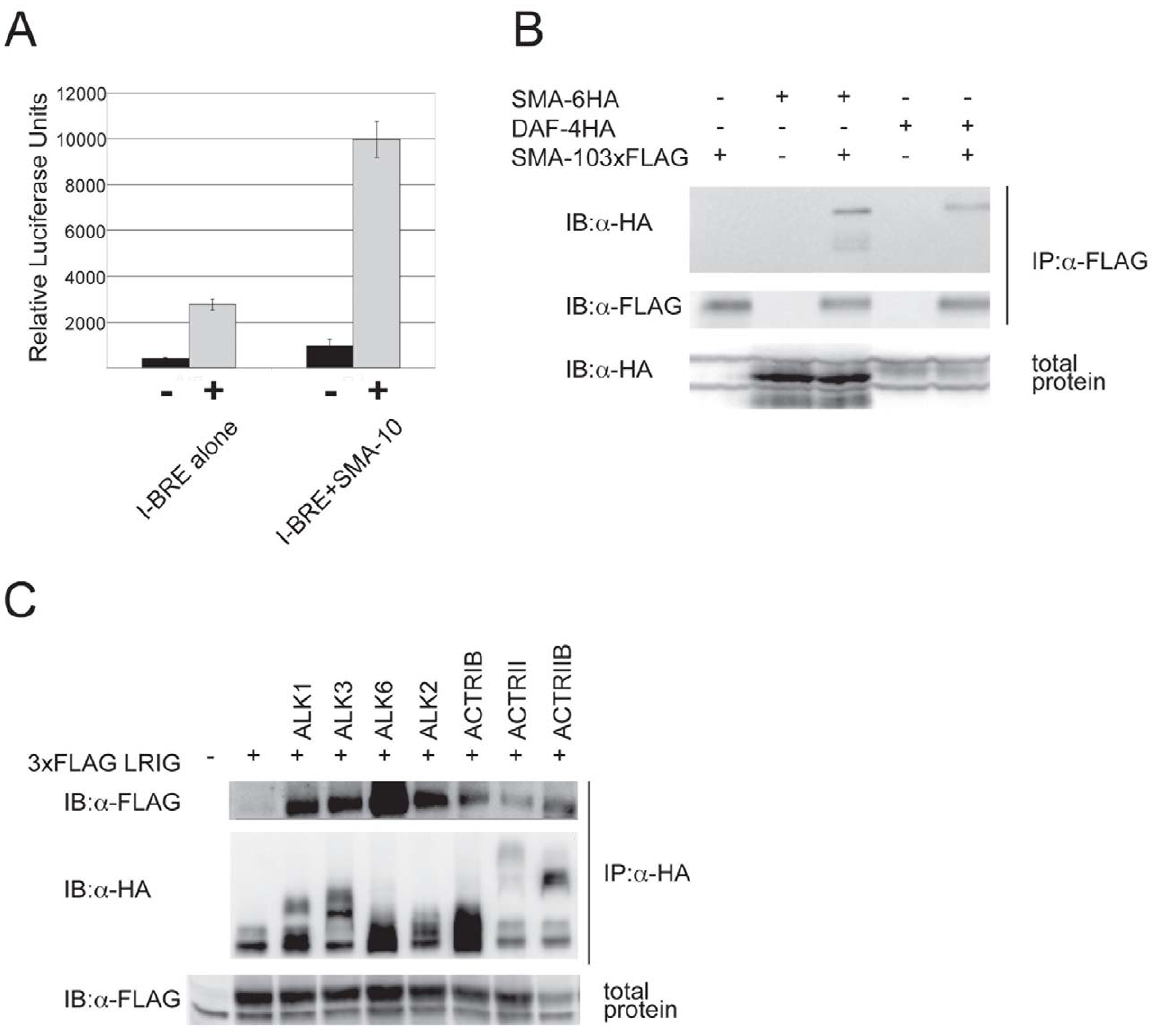
Figure 3. SMA-10 binds BMP receptors and enhances BMP signaling. SMA-10 enhances BMP signaling in HepG2 cells (A). Cells were transfected with a BMP-responsive transcriptional reporter (I-BRE:luciferase) and either SMA-10 or a control vector. Cells were either left unstimulated (black bars) or were stimulated with 2.5 nM BMP2 (grey bars). The average of four transfected wells is shown plus and minus the standard deviation. SMA-10 binds SMA-6 and DAF-4 (B). 293T cells were co-transfected with FLAG-tagged SMA-10 and HA-tagged SMA-6 or DAF-4 receptors. Lysates were immunoprecipitated with anti-FLAG (SMA-10) and blotted for HA (SMA-6 or DAF-4). LRIG1 is able to interact with several mammalian BMP receptors (C). Cells were co-transfected with various HA-tagged BMP receptors and 3x FLAG-tagged LRIG1, then lysates were immunoprecipitated with anti-HA antibody and blotted with anti-FLAG to detect LRIG1.